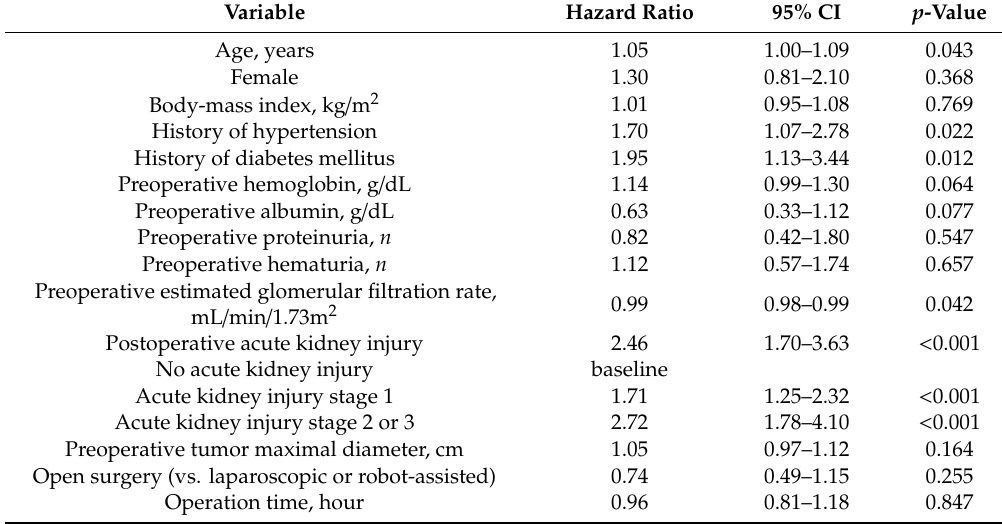
Table 2. Cox proportional hazard regression analysis for new-onset chronic kidney disease or all-cause mortality during the three years after radical nephrectomy in all patients ( n = 558).